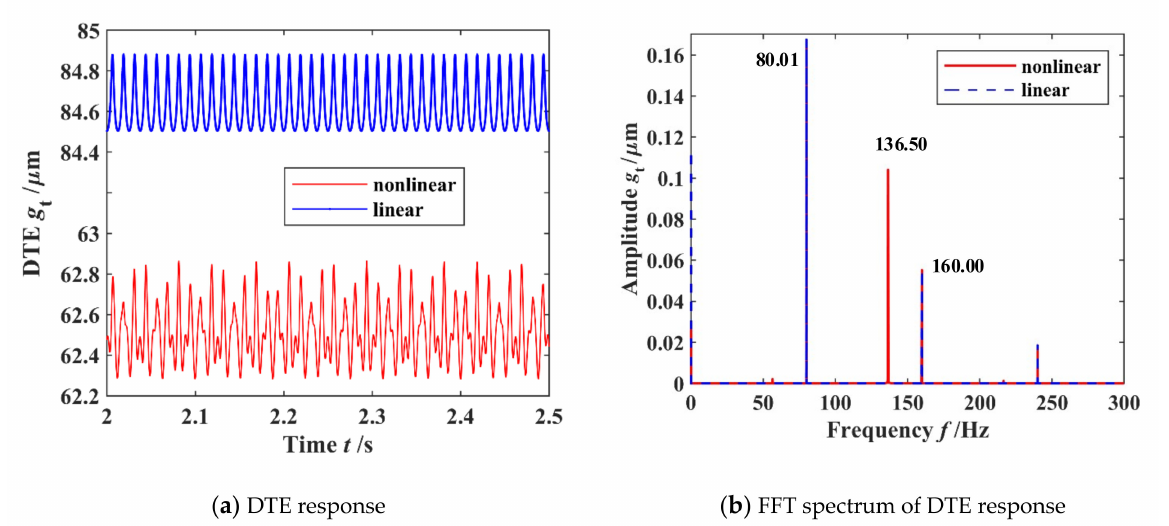
Figure 10. Numerical simulation.